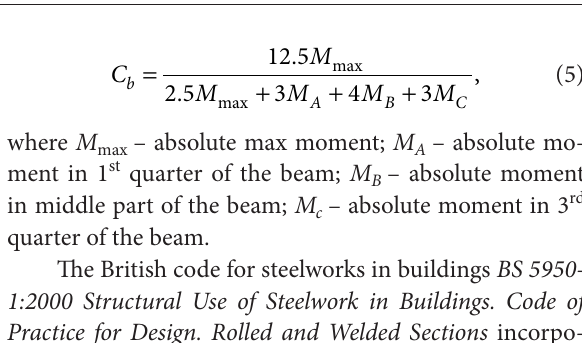
fig. 2. Bending of support double-T